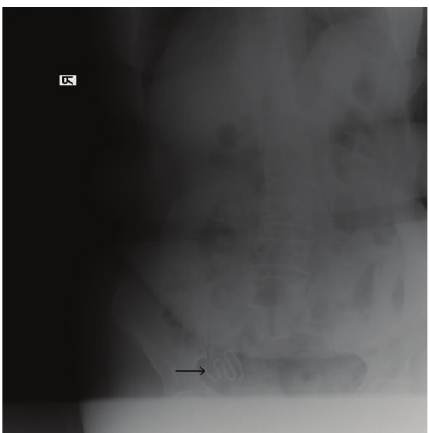
Figure 1: Pelvic X-ray reveals a Lippes loop IUD in the pelvis.